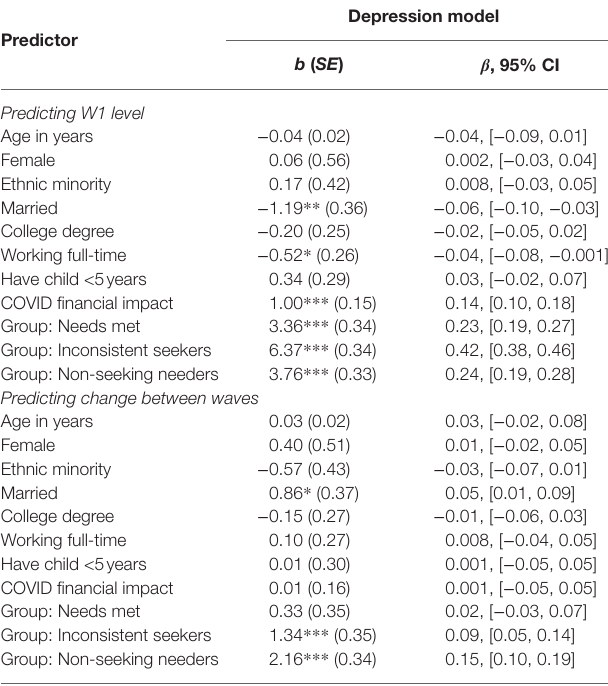
TABLE 2 | Parameter estimates of regression paths in the depression